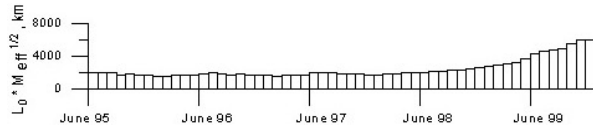
Fig. 8. The long-term variations of the upper ionosphere electron density decay inferred from the IRI model. The decay estimation was done for the middle of the 18:00–21:00UT interval of the mid- dle day of every month during